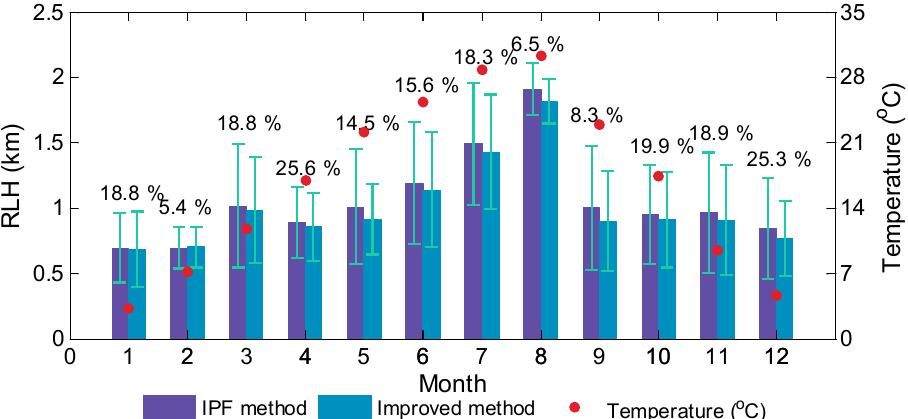
Figure 8. Monthly mean Lidar-derived RLHs using IPF and the improved method over Wuhan between 28 May 2011 and 17 June 2016. The error bars represent the corresponding standard deviations. The red dots refer to the corresponding monthly mean temperature based on the same measuring days of the Lidar. The numbers on the top of each bar represent the measuring percentages for the corresponding month.